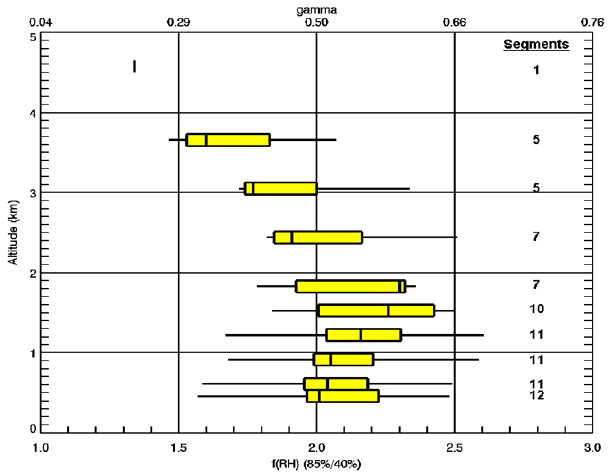
Fig. 12. Cumulative profile plot of the statistical distributions of f(RH) . The number of flight segments at each altitude that comprise the distributions is shown at right. The gamma values were derived by fitting curves as described in Table 2 to the humidified nephelometer measurements. The f(RH) is the scattering hygroscopic growth factor from 40% to 85% RH.